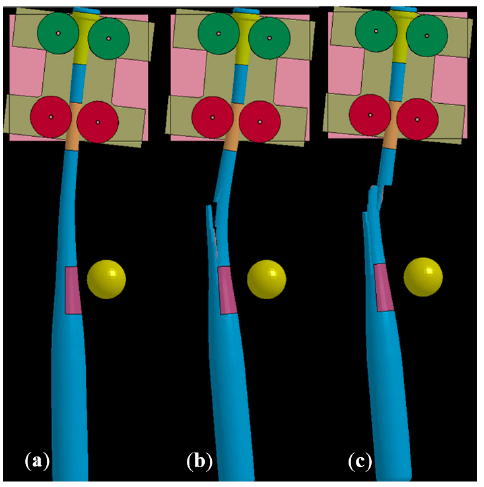
Figure 13. C243 profile impacted at 145 mph (233 kph) at density levels of ( a ) 0.0265 lb/in 3 (733 kg/m 3 ), ( b ) 0.0255 lb/in 3 (706 kg/m 3 ) and ( c ) 0.0245 lb/in 3 (678 kg/m 3